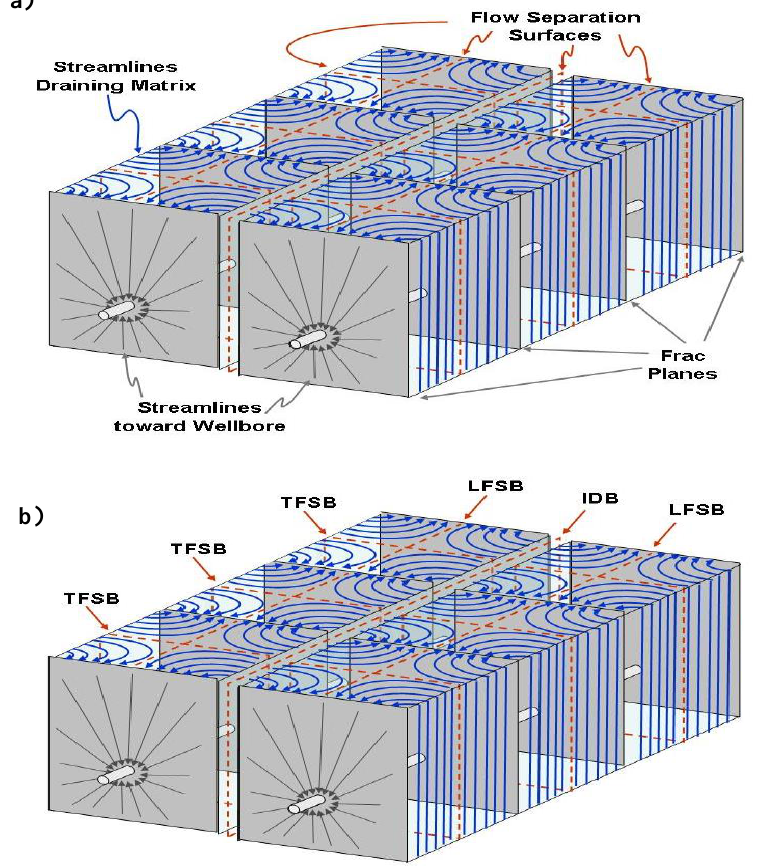
Figure 2. ( a ) Principle sketch of flow separation surfaces between closely spaced, horizontal wells. Vertical fractures are transverse to the wellbore. Flow separation surfaces will also occur between individual fracture planes. Liquid migration from the matrix will approach bi-linear flow near the hydraulic factures. Flow in the fracture planes will be radial toward the perforation zones of the wellbore. ( b ) Flow separation surfaces can be distinguished into Interwell Drainage Boundaries (IDB), Transverse Flow Separation Boundaries (TFSB), and Longitudinal Flow Separation Boundaries (LFSB). After [7].